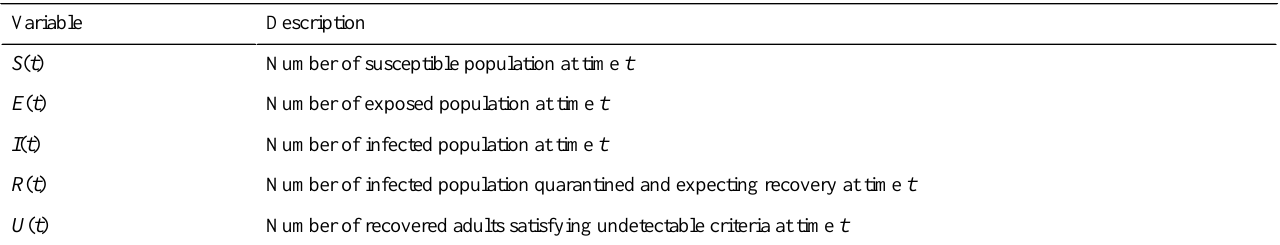
Table 1. The variables for the new deterministic endemic